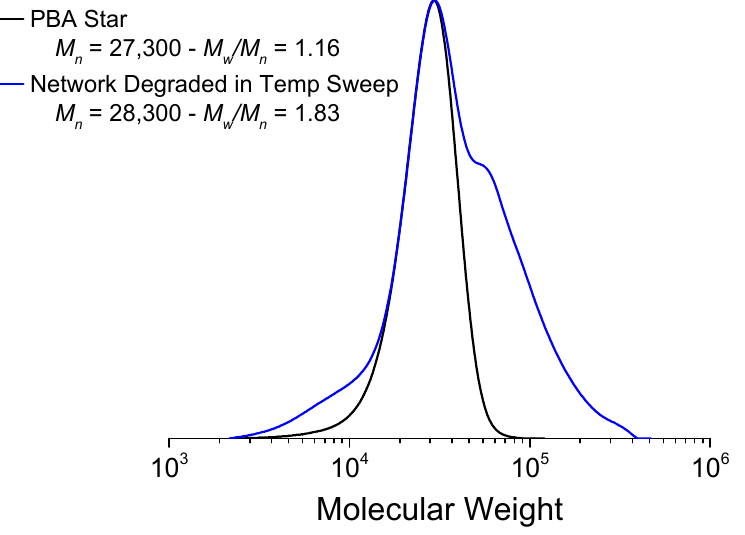
Figure 4. GPC trace of the degraded network after the temperature sweep overlayed with the trace of the PBA 4 Br star polymer precursor. The molecular weight is relative to linear PMMA standards in THF.